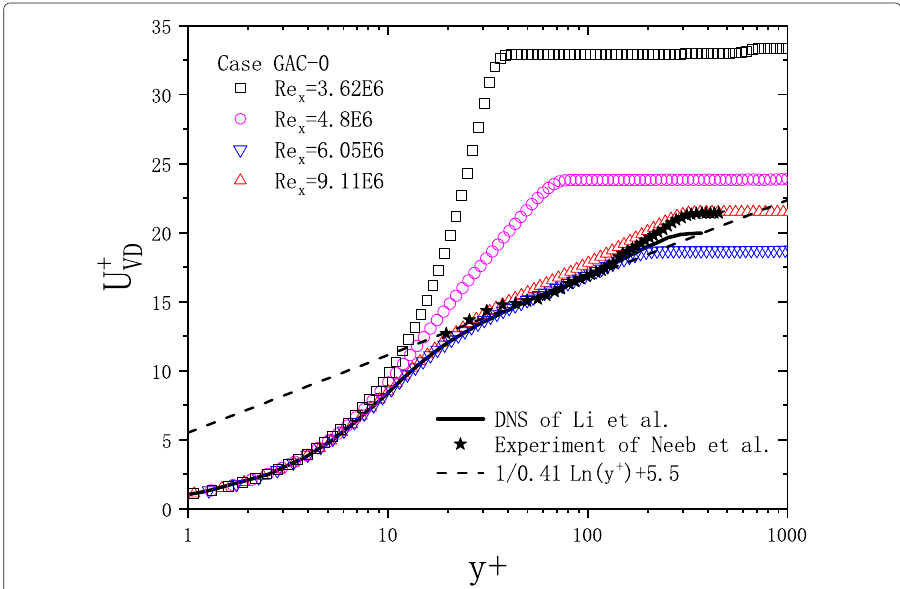
Fig. 7 The van Driest transformed streamwise mean velocity profiles at four streamwise locations for the GAC-0 case. Solid stars denote the experimental data of Neeb et al. for TBL over a 7 ◦ half angle cone at Ma = 6 [32]. Solid line denotes the DNS data of Li et al. for TBL over a 10 ◦ half angle cone at Ma = 0.7